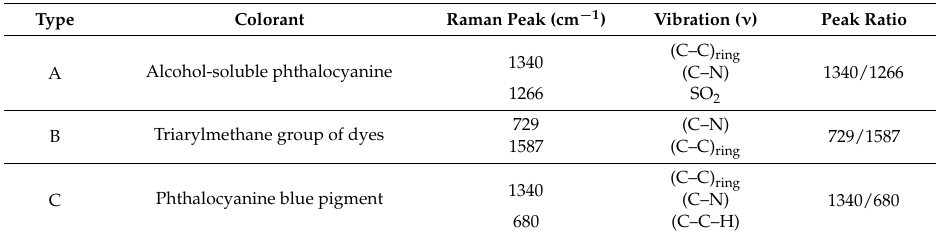
Table 1. The characteristic Raman peaks used for the temporal dependencies